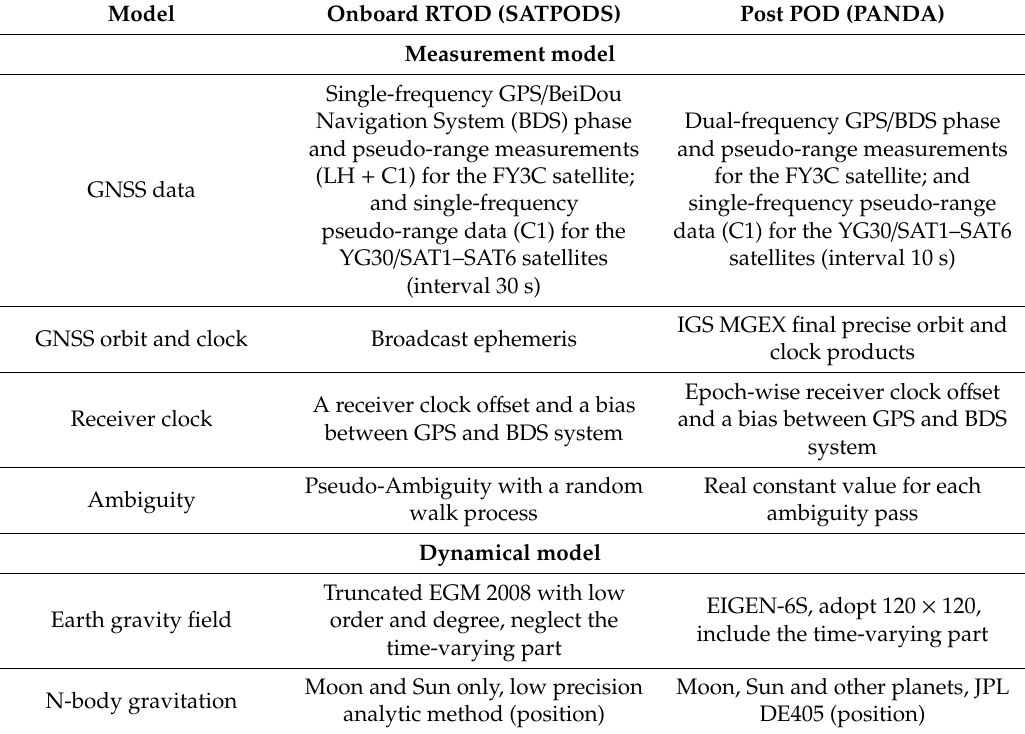
Table 1. Comparison of onboard real-time orbit determination (RTOD) and post POD